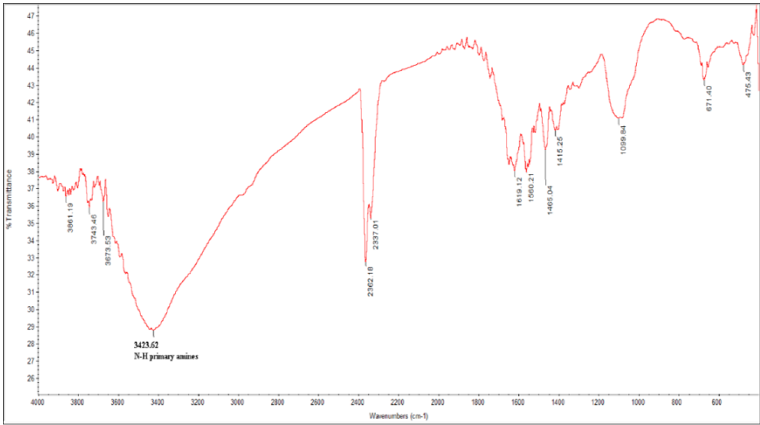
Figure 1. Fourier transformed infrared (FTIR) spectroscopy curve for modified tannin with amino group.